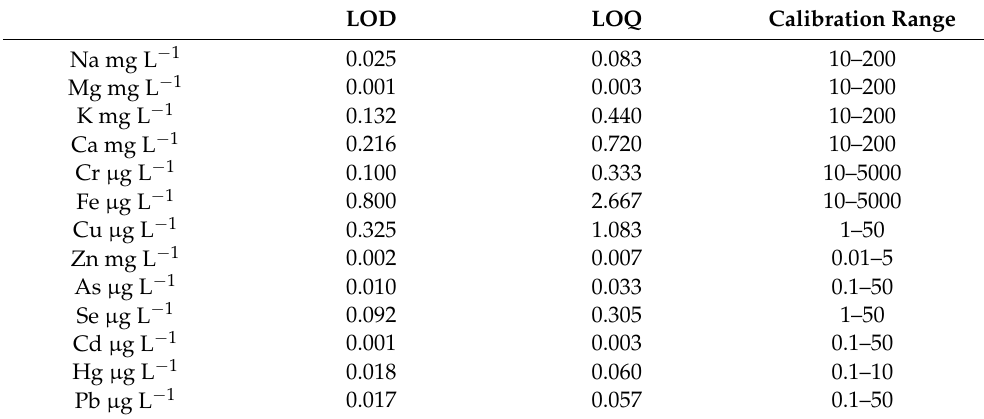
Table A3. Instrumental limit of detection (LOD), limit of quantification (LOQ), and calibration range for inorganic elements quantification by using inductively coupled plasma mass spectrometry. LOD LOQ